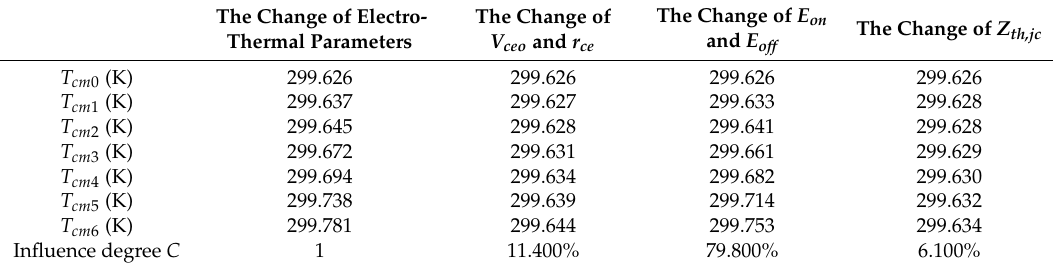
Table 7. The degree of influence of electro-thermal parameters on case